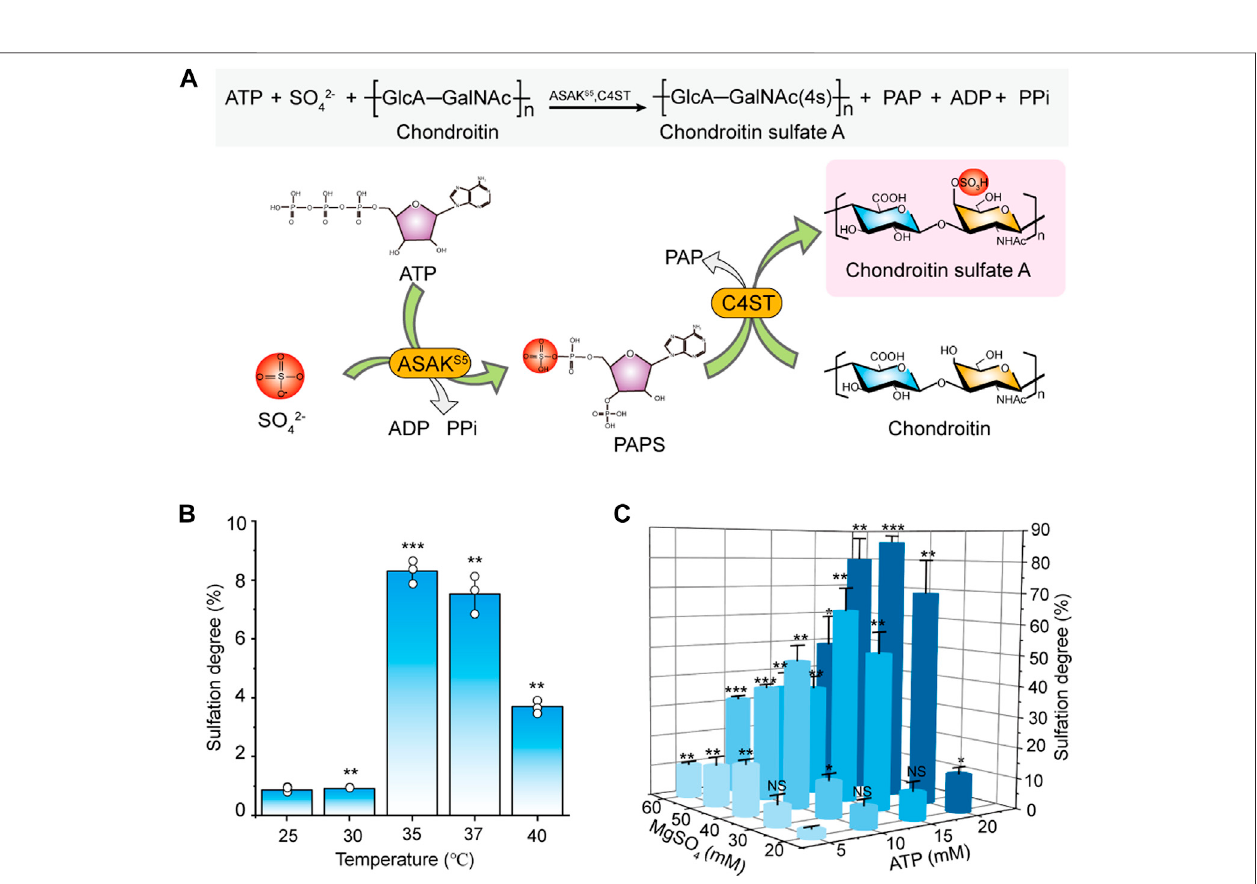
FIGURE 4 | Construction and optimization of the sulfation system from ATP and sulfate. (A) Schematic diagram of sulfation-modi fi cation system for CSA biosynthesis. (B) Theeffectoftemperatureonsulfationinthereactionsystemwith10 mMATP,20 mMMgSO 4 ,0.5 g/LASAK S5 ,1.0 g/LC4ST,and2.0 g/Lchondroitin for48 h. (C) TheeffectofATPconcentrationandMgSO 4 concentrationonthesulfationinthesystemwithASAK S5 (0.5 g/L),C4ST(1.0 g/L)andchondroitin(2.0 g/L)ata reaction temperature of 35 ° C for 48 h. ATP, adenosine 5 ′ -triphosphate; ADP, adenosine 5 ′ -diphosphate; PAPS, 3 ′ -phosphoadenosine-5 ′ -phosphosulfate; PPi, pyrophosphate;ASAK S5 ,abifunctionalPAPSsynthasethatconvertsATPtoPAPS.Thedataareexpressedasthemean±SDfromthree( n =3)biologicallyindependent replicates. The statistical analysis was performed by two-sided t -test. * p < 0.05, ** p < 0.01, *** p < 0.001; NS not signi fi cant ( p ≥ 0.05).